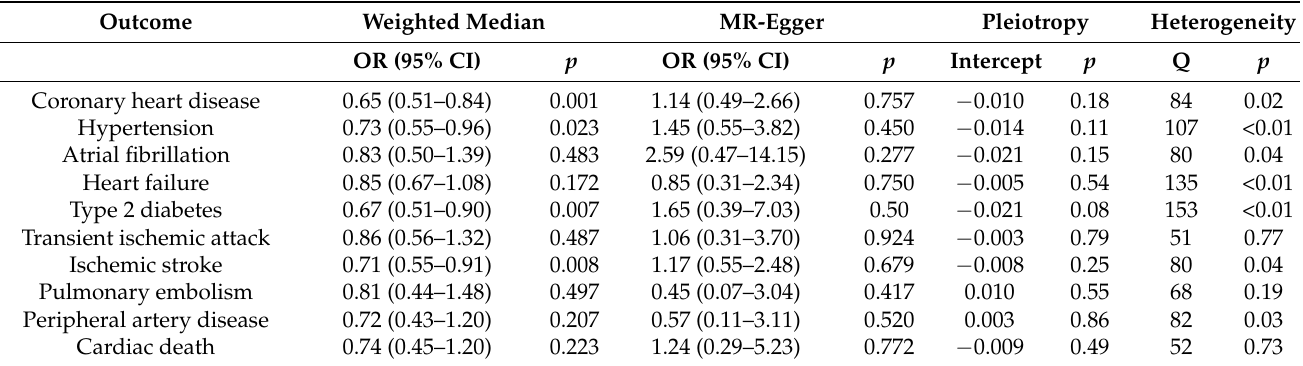
Table 1. Associations between genetically predicted cheese intake and cardioartery disease in sensitivity analyses using the weighted-median and MR-Egger methods.